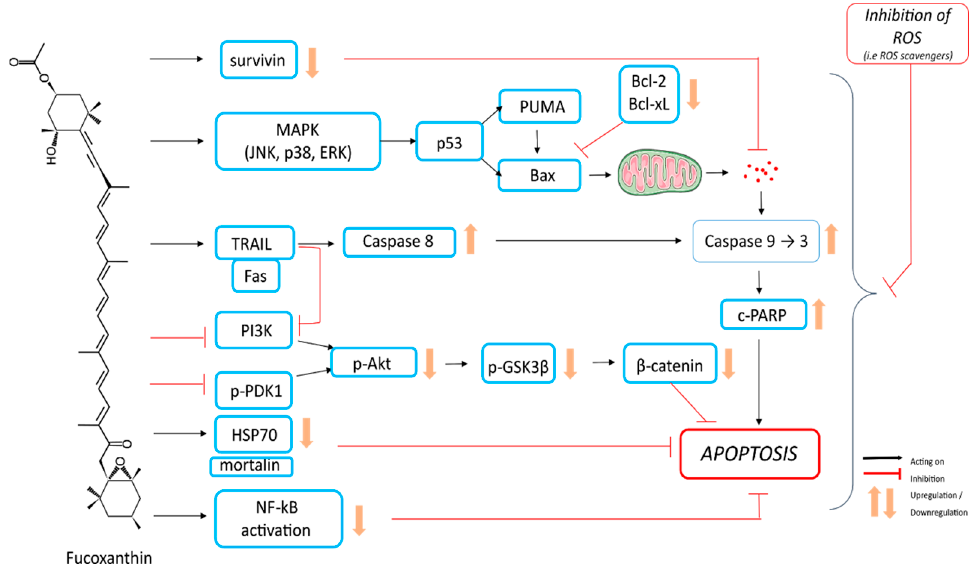
Figure 4. Induction of apoptosis in cancer cells by fucoxanthin.